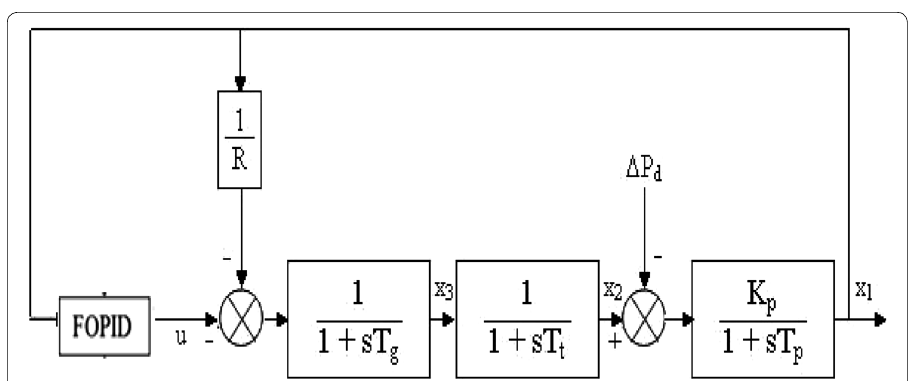
Fig. 1 Block diagram of single-area